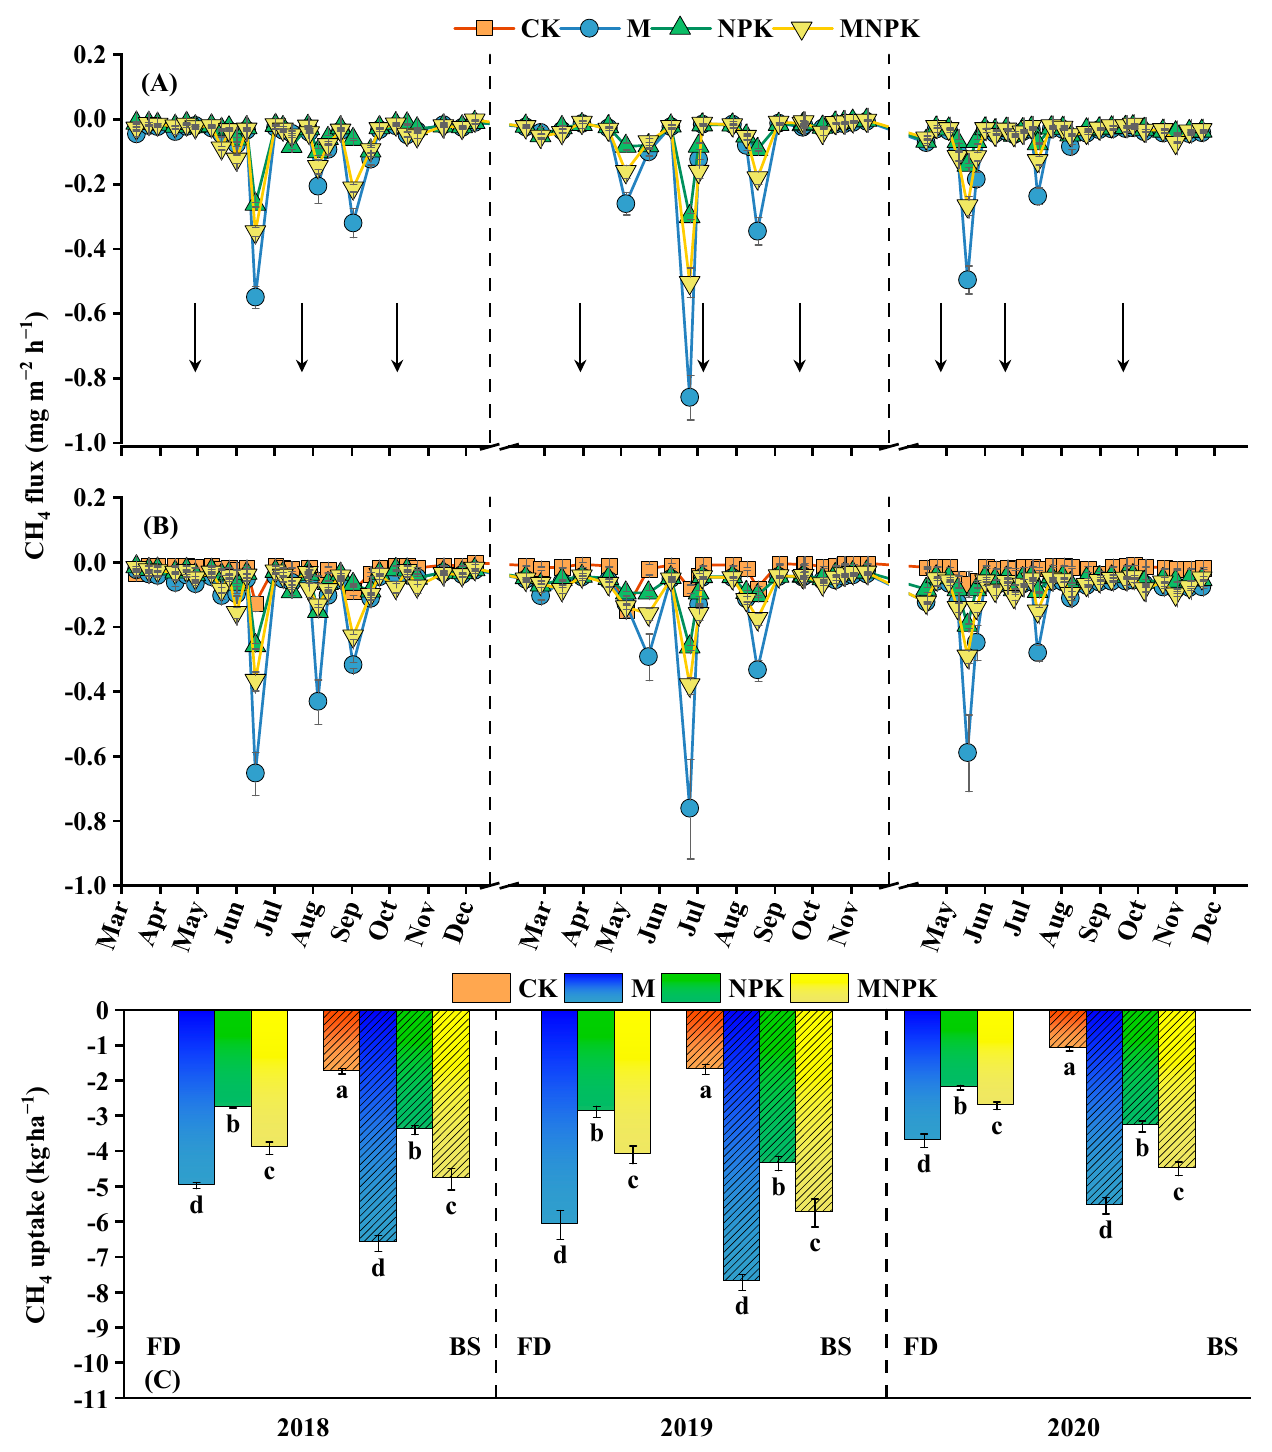
Figure 6. Variation in CH 4 fluxes under different treatments. ( A ) FD: Fertilizer ditches, ( B ) BS: Bare soil sites, ( C ) annual cumulative CH 4 uptake from different treatments. CK: control, M: organic ma- nure, NPK: chemical fertilizer, MNPK: chemical fertilizer combined with organic manure. The data points indicate the means of the three replicates. The error bars indicate the standard error (±SE), and the black arrows indicate nitrogen fertilizer applications, the difference in lowercase letters in- dicate significant differences between the treatments ( p < 0.05).